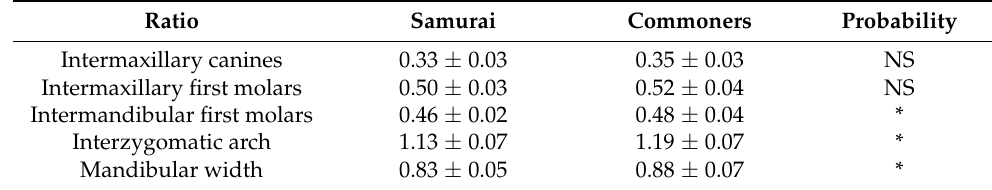
Figure 6. Comparison of the maxillary and mandibular width ratio between samurai and common- ers. Values are presented as means ± standard deviations. The asterisks represent significant differ- ences between the groups. Black, samurai group; grey, commoners.